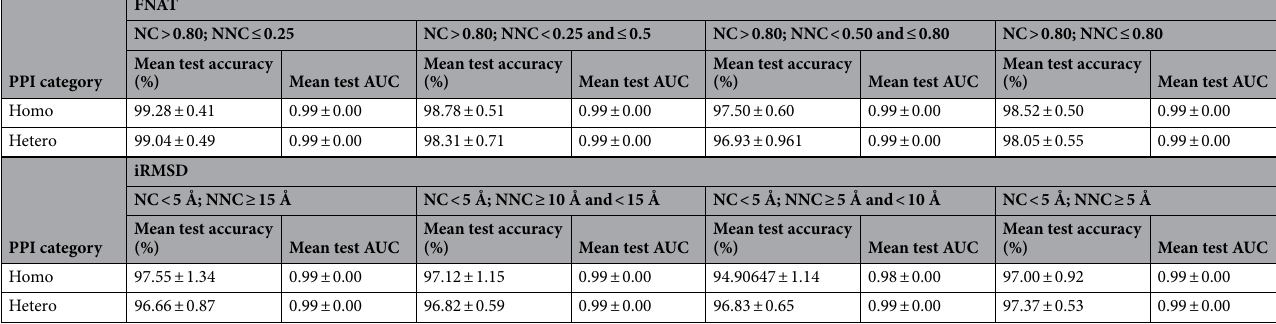
Table 1. Mean test and train accuracies for prediction of protein–protein interaction interfaces. NC, native cutoff; NNC, non-native cutoff. Mean and SD were calculated from 100 randomized cross-validations using the 20% testing